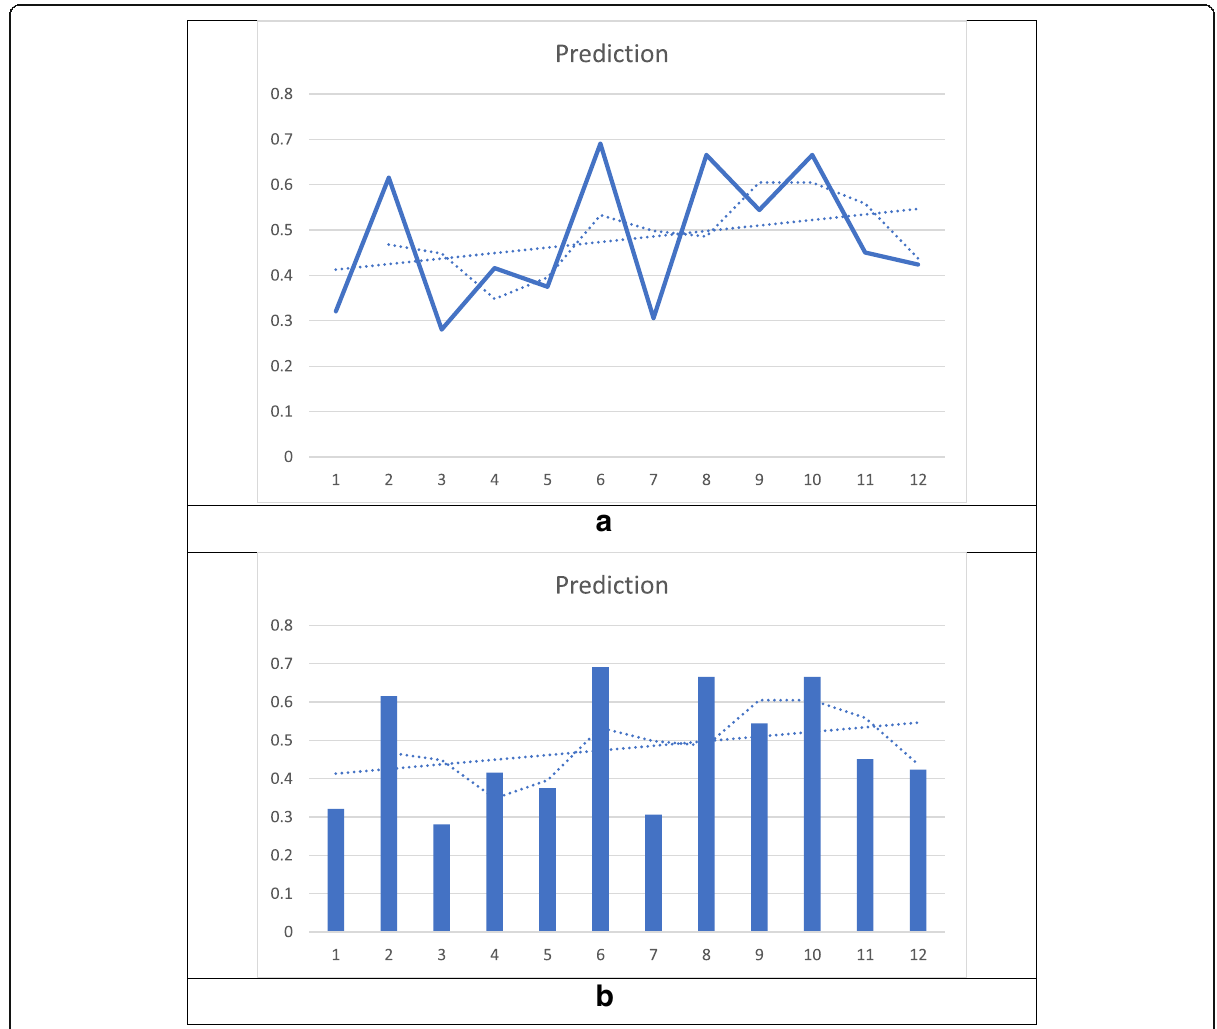
Fig. 13 a GRBF-NN prediction vs. Linear Prediction [21]. Fig. 13b: GRBF-NN prediction vs. Linear Prediction